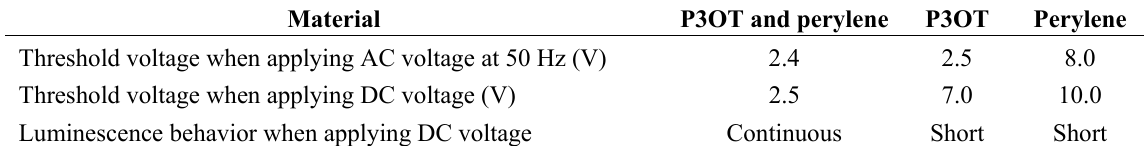
Table 1. Threshold voltages under the application of AC voltage at 50 Hz and DC voltage, and the luminescence behavior when applying DC voltage from the ECL device